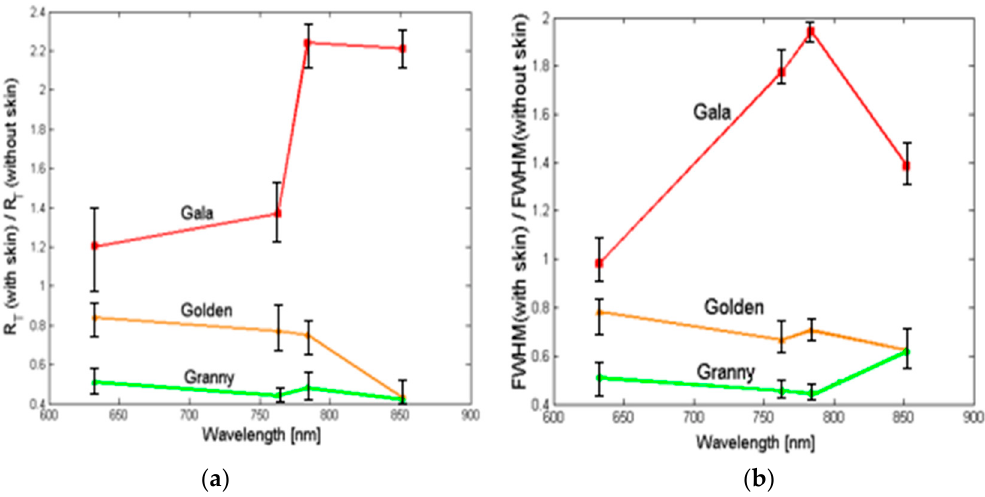
Figure 5. Evolution of the ratios ( a ) α R and ( b ) α F as a function of the wavelength, for three apple cultivars with and without skin.